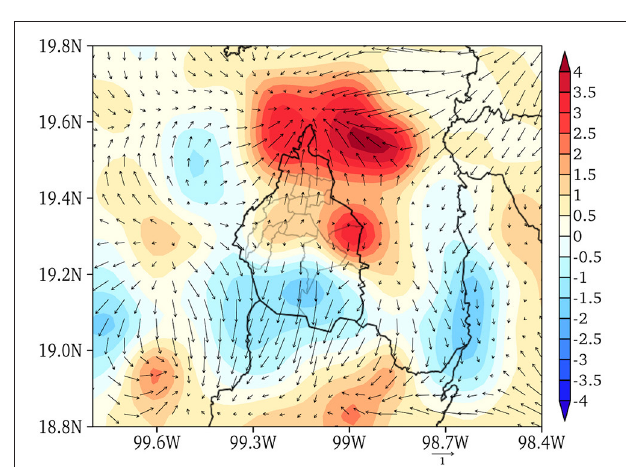
FIGURE 9 | Sensitivity experiment with urban area of MCMA modified. 2m air temperature ( ◦ C) difference for July 2014 between the control and the modified experiment at 17:00 UTC is shown in shading. The vectors show the 10m wind differences (m/s).